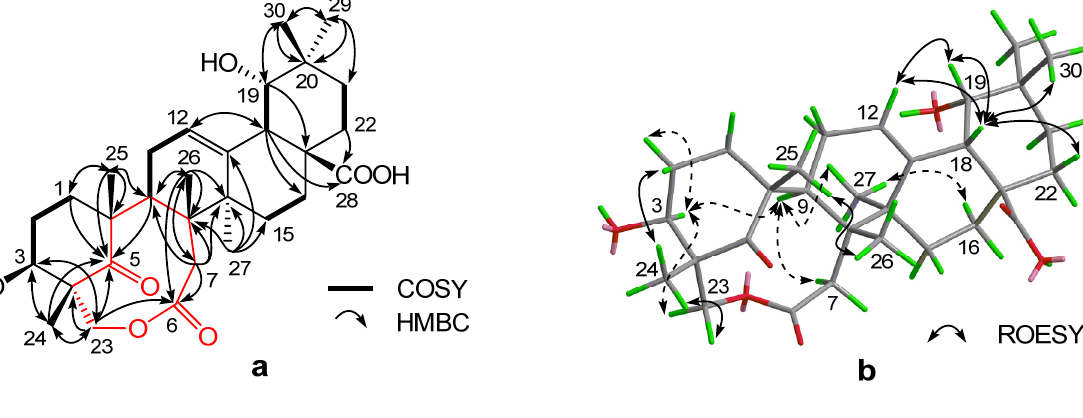
Figure 2. 1 H- 1 H-COSY and selected HMBC correlations of 2 ( a ); Selected key ROESY correlations of 2 ( b